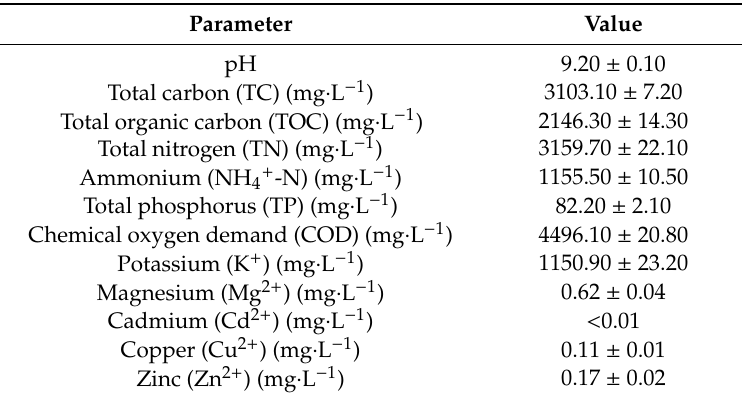
Table 1. Characteristics of the collected pig